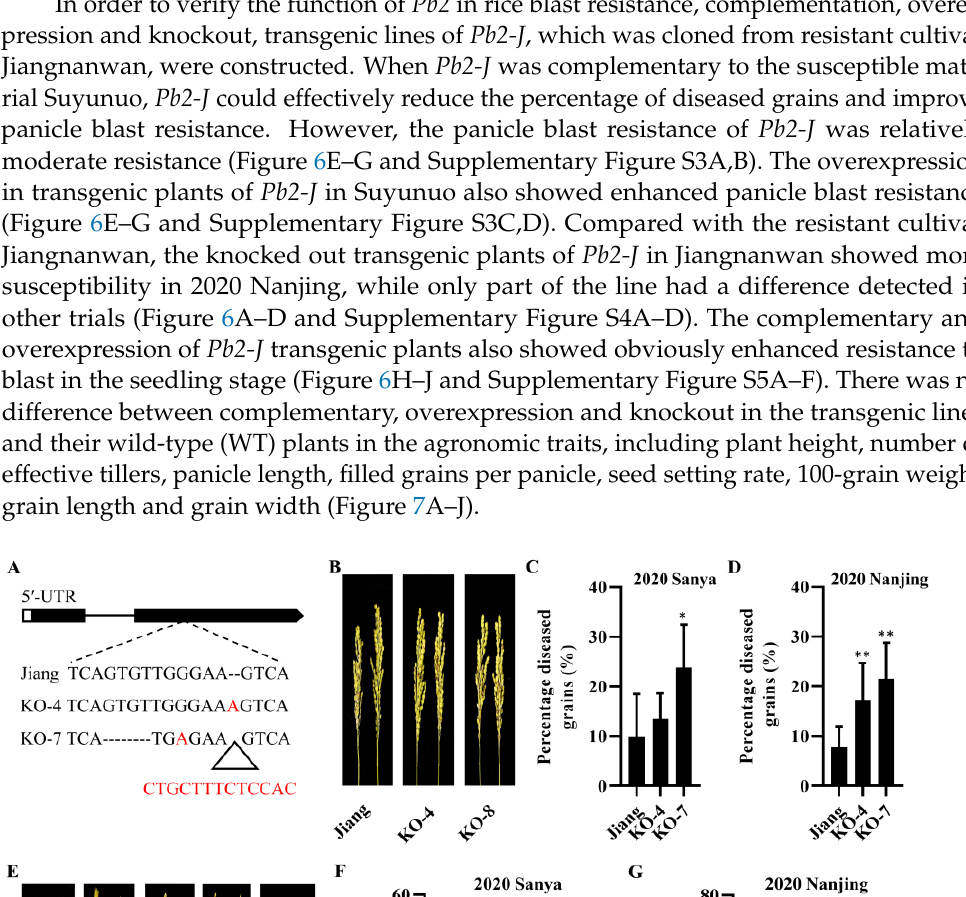
Figure 6. Pb2 can significantly reduce the number of diseased grains and leaf diseased spots. ( A ) Gene structure of Pb2 and two types of mutation. ( B , E ) Rice panicle three weeks after injection of Hoku1 spore suspension at booting stage, Nanjing, 2020. Jiang represents the CRISPR-Cas9 trans- genic receptor plant and Su represents the complementary and overexpressing transgenic receptor plant. ( C , D , F , G ) Percentage diseased grains (%) of transgenic lines and WT was counted three weeks after inoculation, and each bar represents the average of nine panicles. ( H ) Response of three- week-old seedlings 6 days after inoculation with Hoku1 . ( I , J ) Average lesion length and average number of lesions in WT and transgenic plants. Lesion length and lesion number were measured 6 days after inoculation. Error bars represent standard deviation, and differences between WT and experimental groups were tested with GraphPad Prism 8.3 t -test, * p < 0.05, ** p < 0.01.